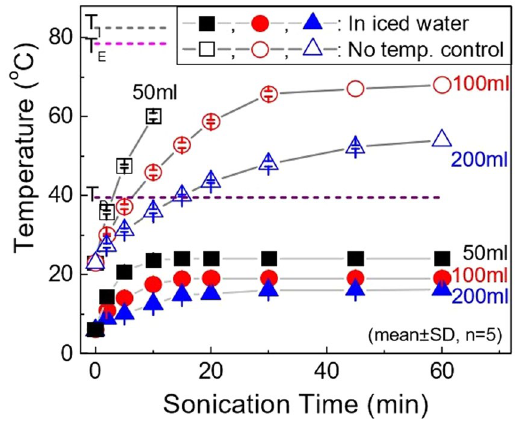
Figure 5. Temperature profiles of emulsion prepared with different sonication conditions. Three different sample volumes were emulsified with different sonication times (5, 10, 15, 30, and 60 min) by sonication at 30 W for temperature monitoring: no temp. control (sonication at room temperature, i.e. R.T. sonication) and in iced water (temperature of sample being controlled by iced water during sonication, i.e. iced water sonication) ( n = 5, mean ±